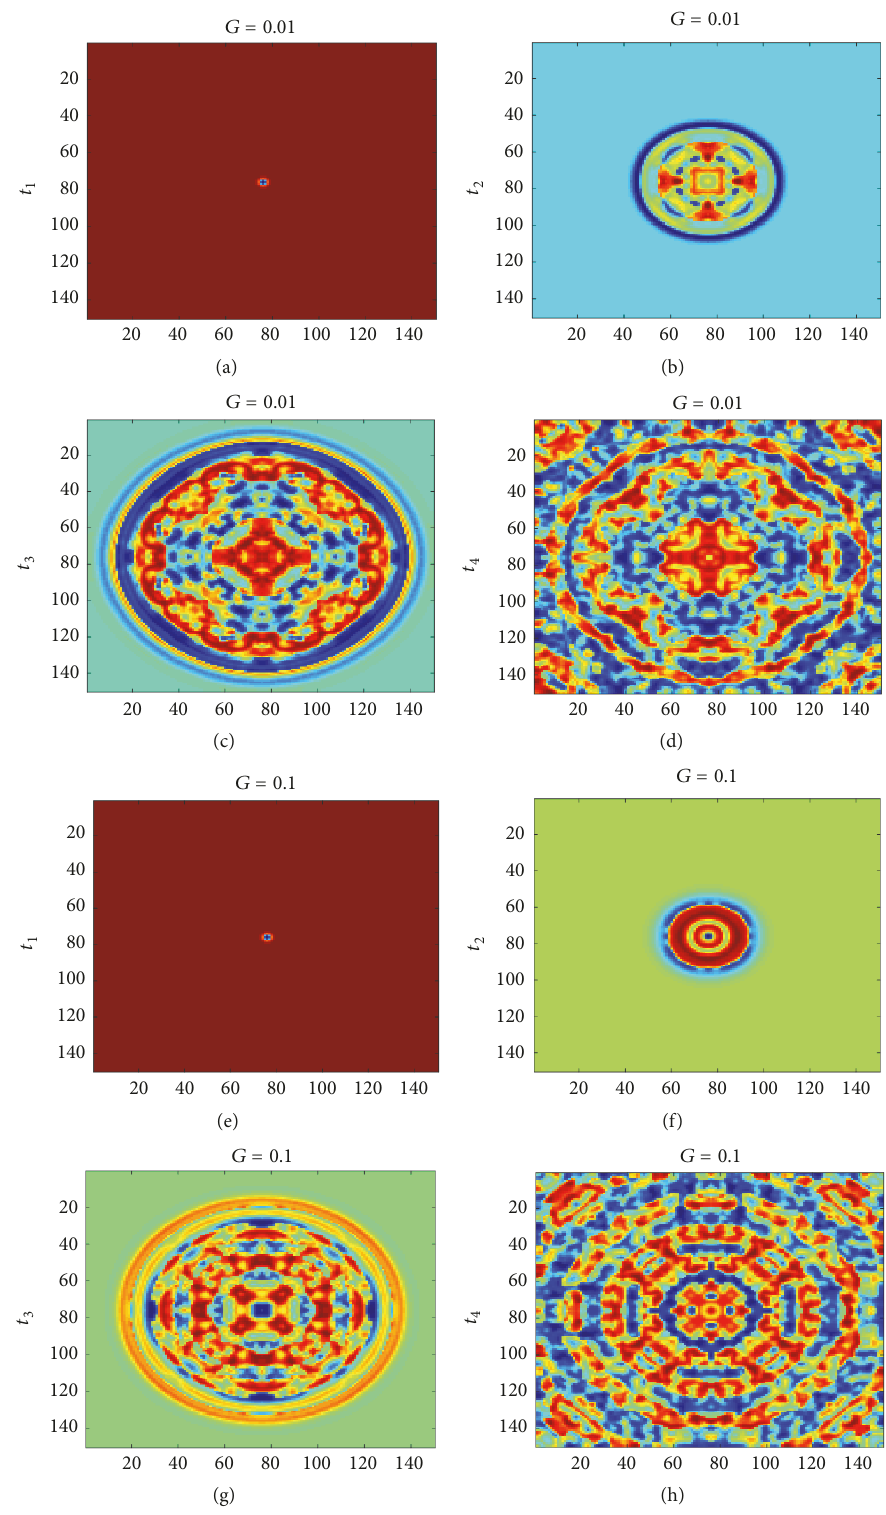
Figure 18: The snapshots of spatial distribution of membrane potential with color scale for neurons in the square array network for 𝑘 = 0.8 and 𝐷 = 1 at 𝑡 1 = 2 time units, 𝑡 2 = 75 time units, 𝑡 3 = 170 time units, and 𝑡 4 = 300 time units. ((a)–(d)) 𝐺 = 0.01 and ((e)–(h)) 𝐺 = 0.1